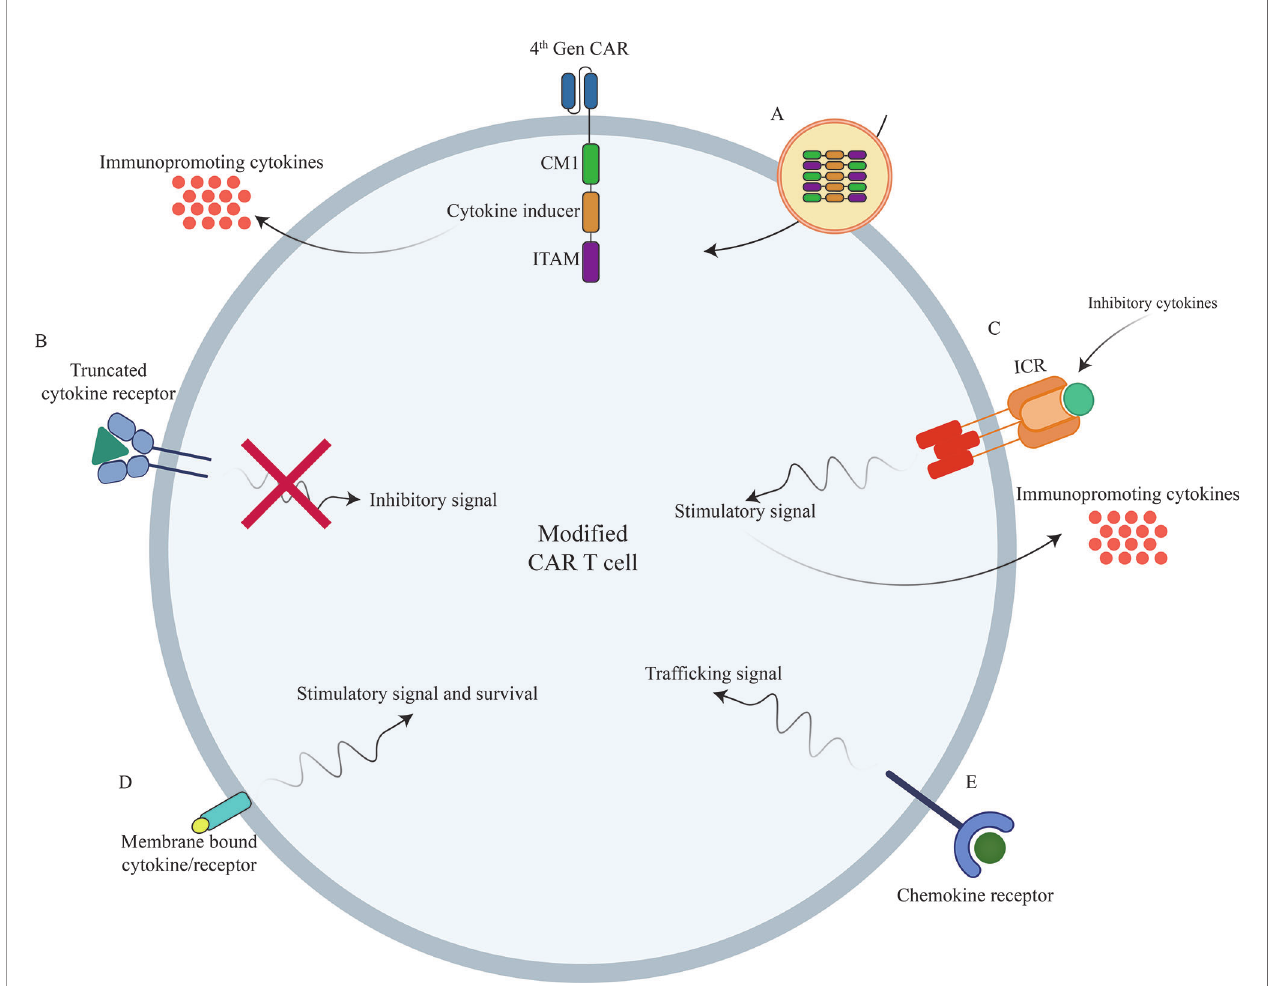
FIGURE 2 | Novel strategies to boost CAR T cells ef fi cacy against different types of tumors using genetic manipulations of different cytokines/chemokines and their receptors. (A) Incorporation of different cytokines/chemokines or their signaling domains in CAR construct. (B) Inclusion of truncated cytokine receptors lacking intracellular signaling domain. (C) Incorporation of inverted cytokine receptors (ICRs) to convert immunosuppressive signals to immunopromoting signals (D) Incorporation of membrane-tethered cytokine to provoke certain signal transduction of through its receptor. (E) Overexpression of chemokine receptors to improve CAR T cell traf fi cking into the tumor sites. CAR, Chimeric Antigen Receptor; TCR, T Cell Receptor; ICR, Inverted Cytokine